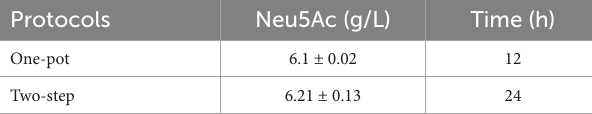
TABLE 1 The catalytic efficiency of two